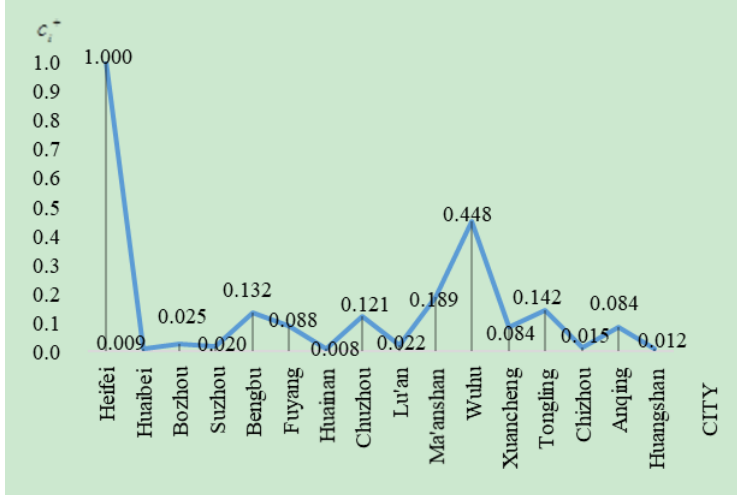
Figure 4. The comparison of economic sustainability of cities in Anhui province.